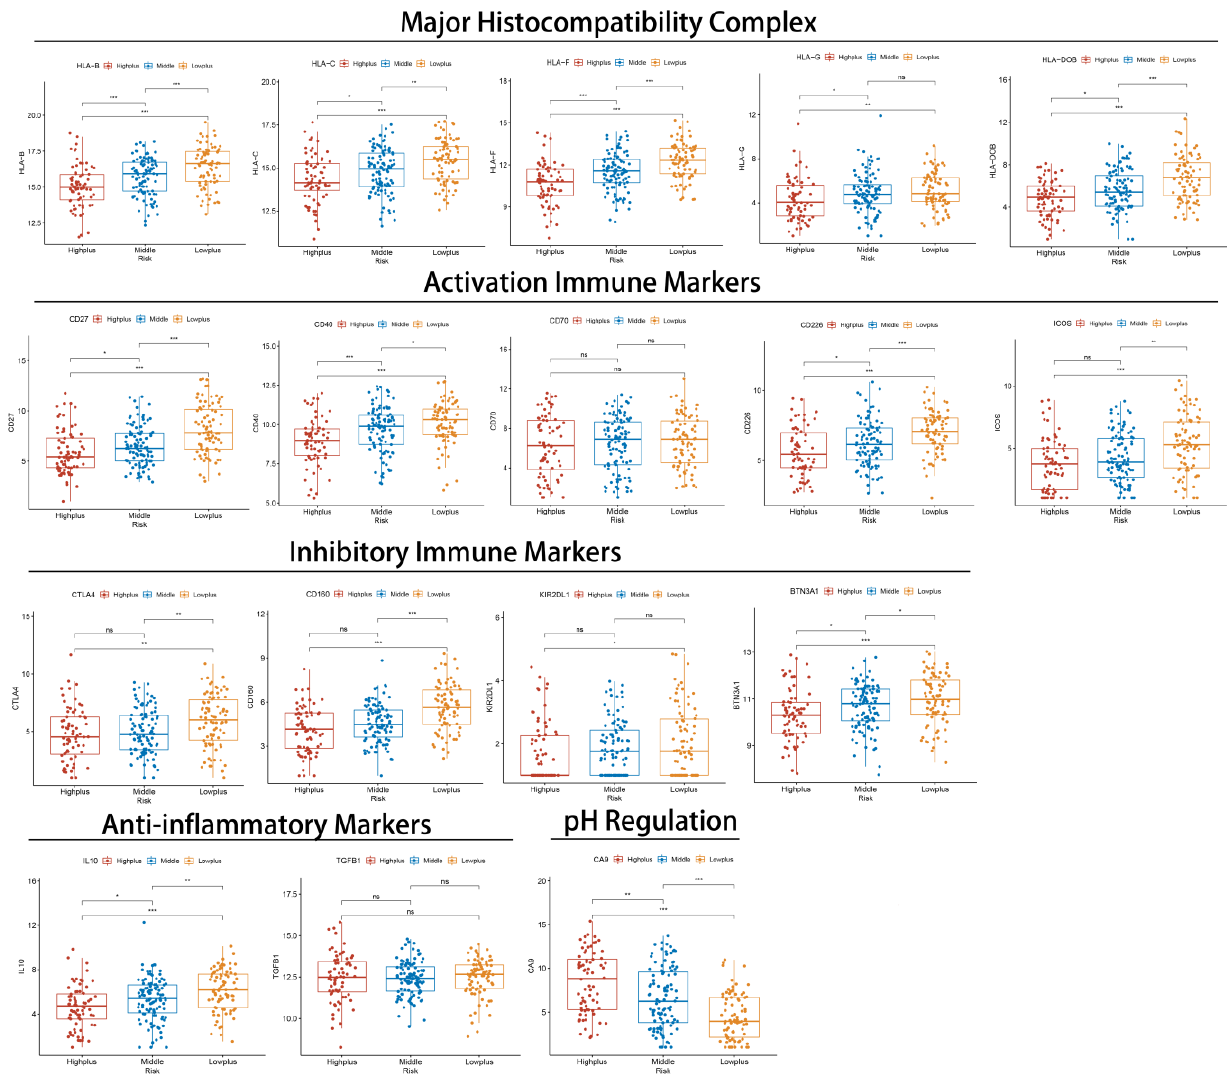
Figure 6. The relationship between immune-related markers and Hypoxia-TME classifiers in three subgroups. Normalized expression of selected markers represented by box and whisker plots. ns, p ≥ 0.05; *, 0.01 ≤ p < 0.05; **, 0.001 ≤ p < 0.01; ***, 0.0001 ≤ p < 0.001.